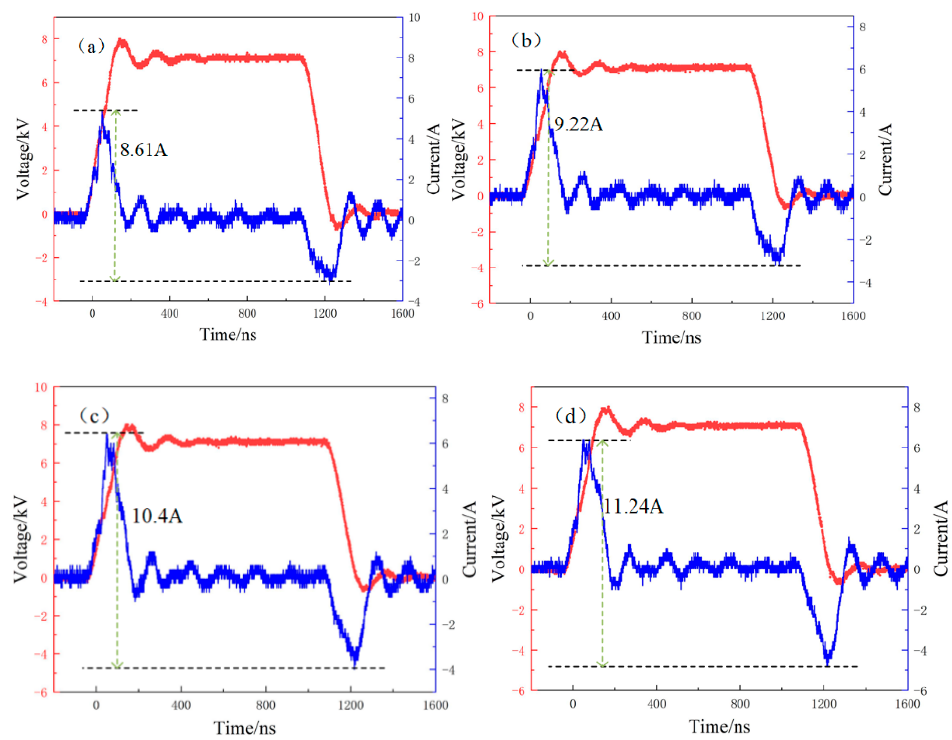
Figure 10. Current (blue line) and voltage (red line) discharge waveforms of nanosecond-pulsed dielectric-barrier discharge at pressures of ( a ) 70 kPa, ( b ) 60 kPa, ( c ) 50 kPa, and ( d ) 40 kPa.